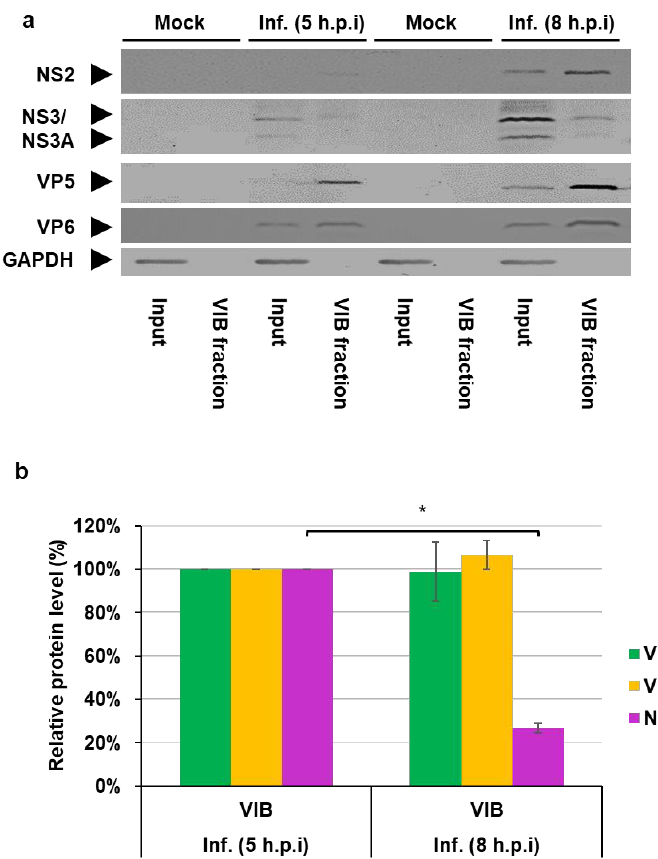
Figure 4. NS3 association with VIBs decreases during the BTV replication cycle. Analysis of cell lysates of mock and infected BSR cells. ( a ) Western blot detection of the viral proteins NS2, VP5, VP6, NS3, and host cell GAPDH at 5 and 8 h.p.i from differential velocity centrifugation for VIBS from cells infected at an MOI of 5. ( b ) Densitometry analysis of the Western blots (a) expressed as a percentage, normalized to NS2. Error bars represent the SD values from three independent experiments. * p < 0.01.